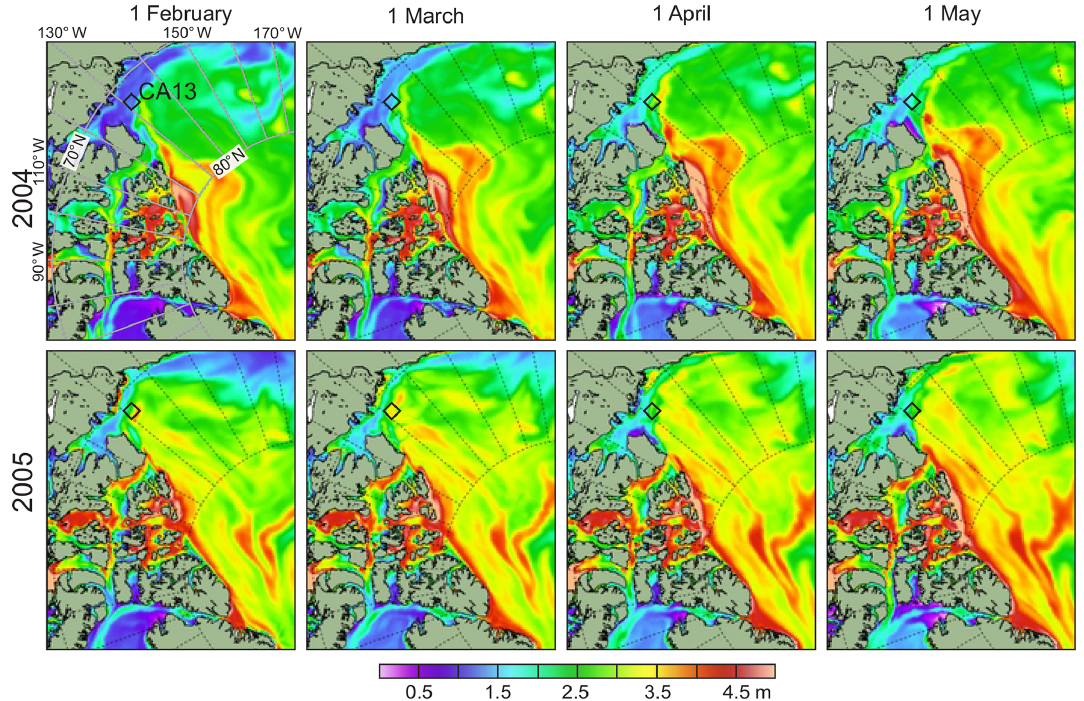
Figure 4. Spatial distribution of sea-ice thickness (m) based on model simulations using DMI’s ocean and sea-ice model HYCOM + CICE for February–May 2004 (top) and 2005 (bottom). The black diamonds depict the mooring